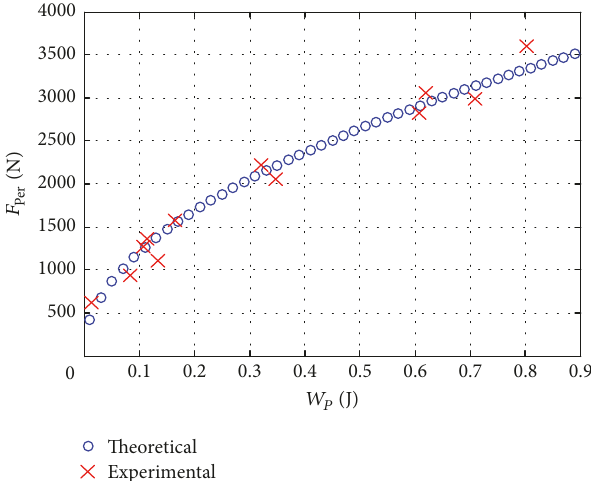
Figure 9: Maximum impact load on the lunar rock simulant with the percussion energy increase.